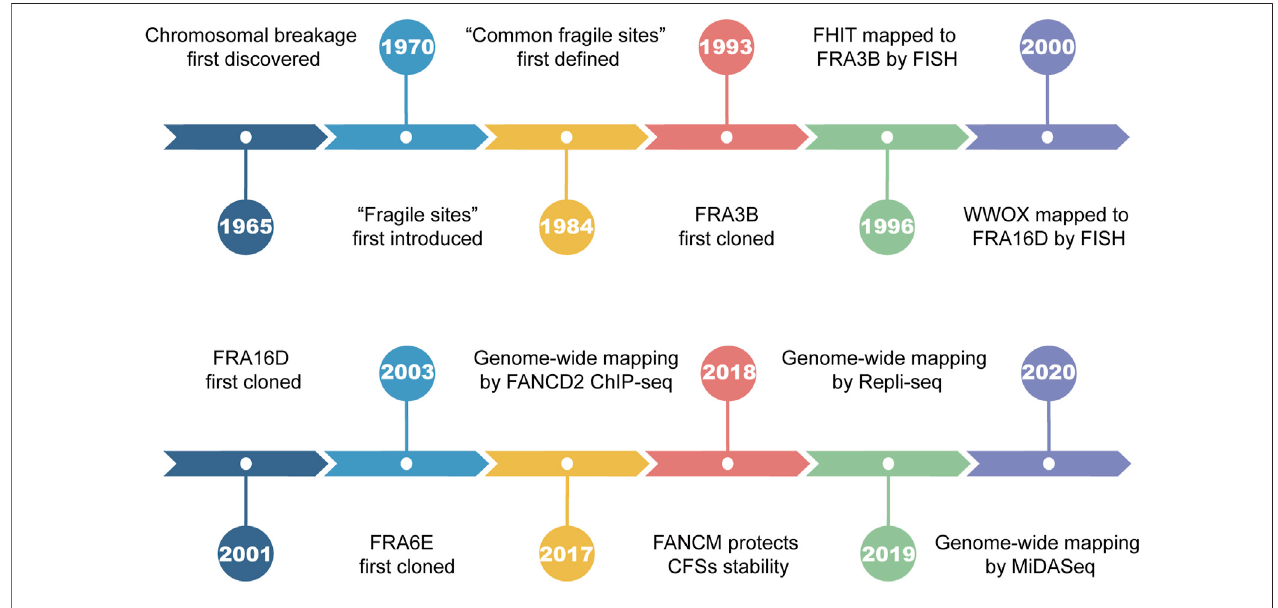
FIGURE 1 | Landmark events in the history of common fragile